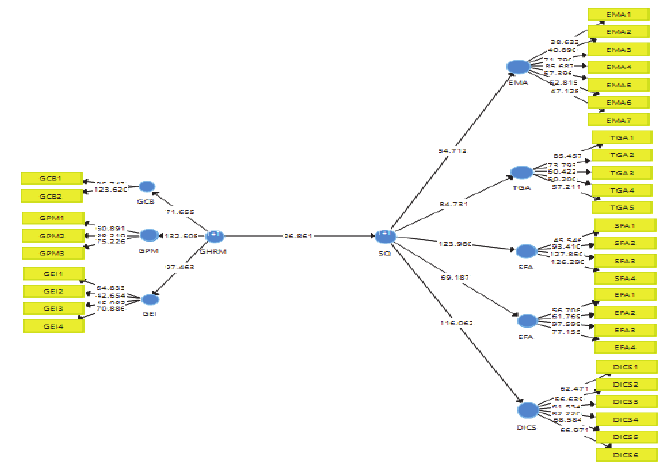
Fig. 2. Pls Bootstrapping GHRM to Service Quality